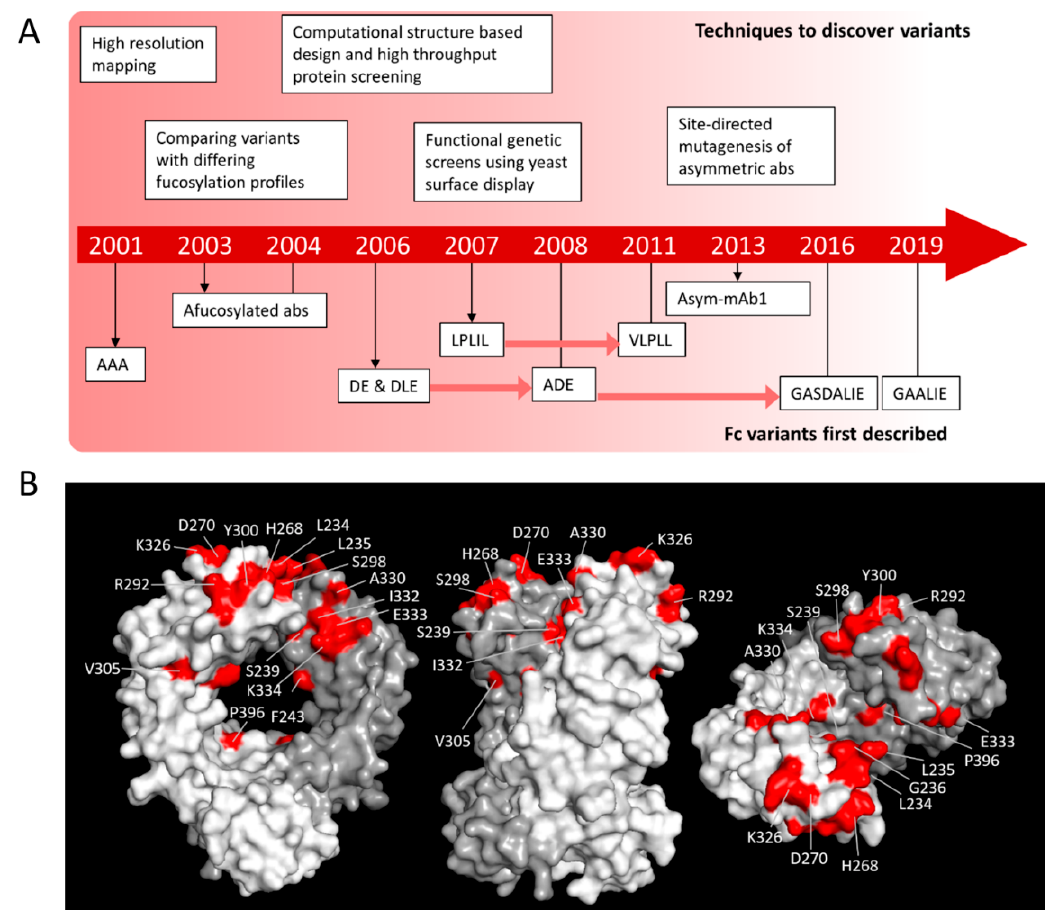
Figure 1. Fragment crystallizable (Fc) modifications which augment antibody e ff ector function. ( A ) Timeline of events detailing techniques used to discover variants with enhanced e ff ector cell function and when the Fc variants were first described [40–48]. Letters refer to the common notation of the introduced amino acid substitutions as discussed in the main text. ( B ) Previously identified point mutations within the Fc that impact e ff ector cell function annotated on a hIgG1 Fc crystal structure model (PDB: 3AVE; [49,50]) and detailed in Table